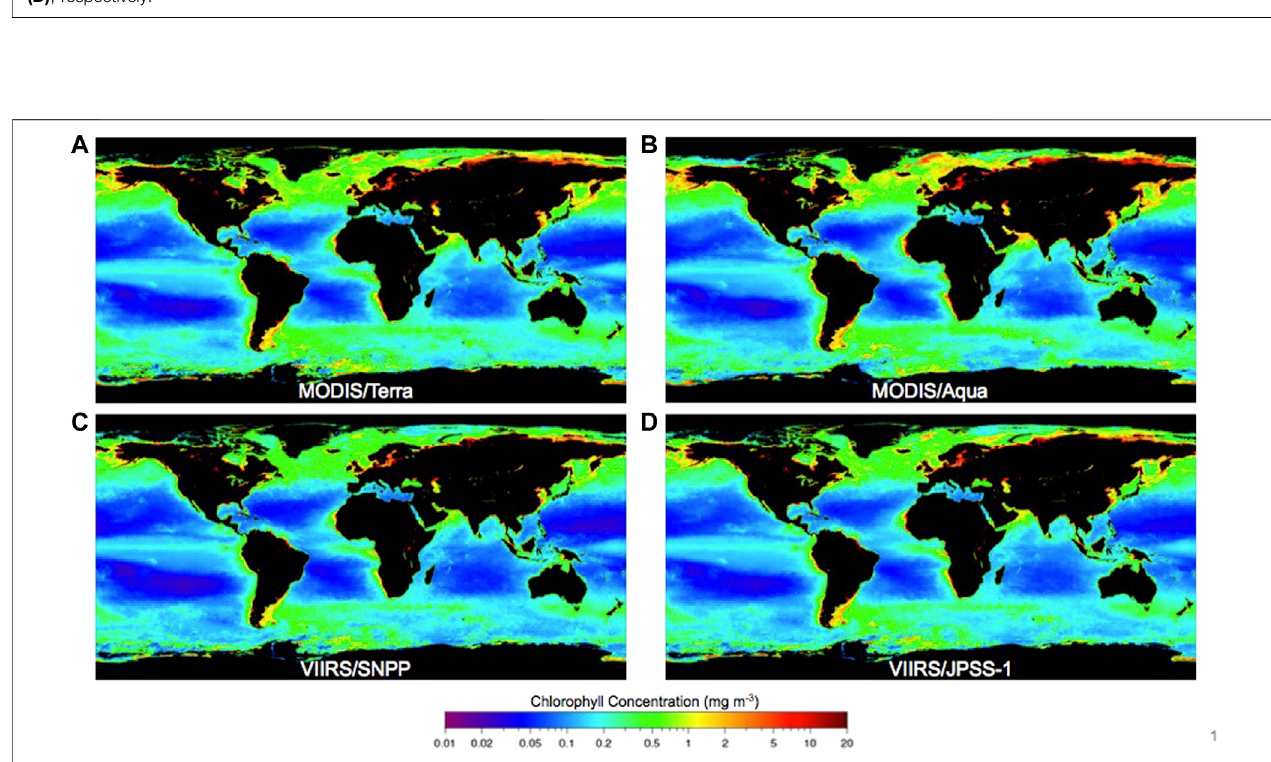
FIGURE 2 | Global annual average chla composites derived from Terra/MODIS (A) , Aqua/MODIS (B) , SNPP/VIIRS (C) , and JPSS-1/VIIRS (D) for the year 2020.